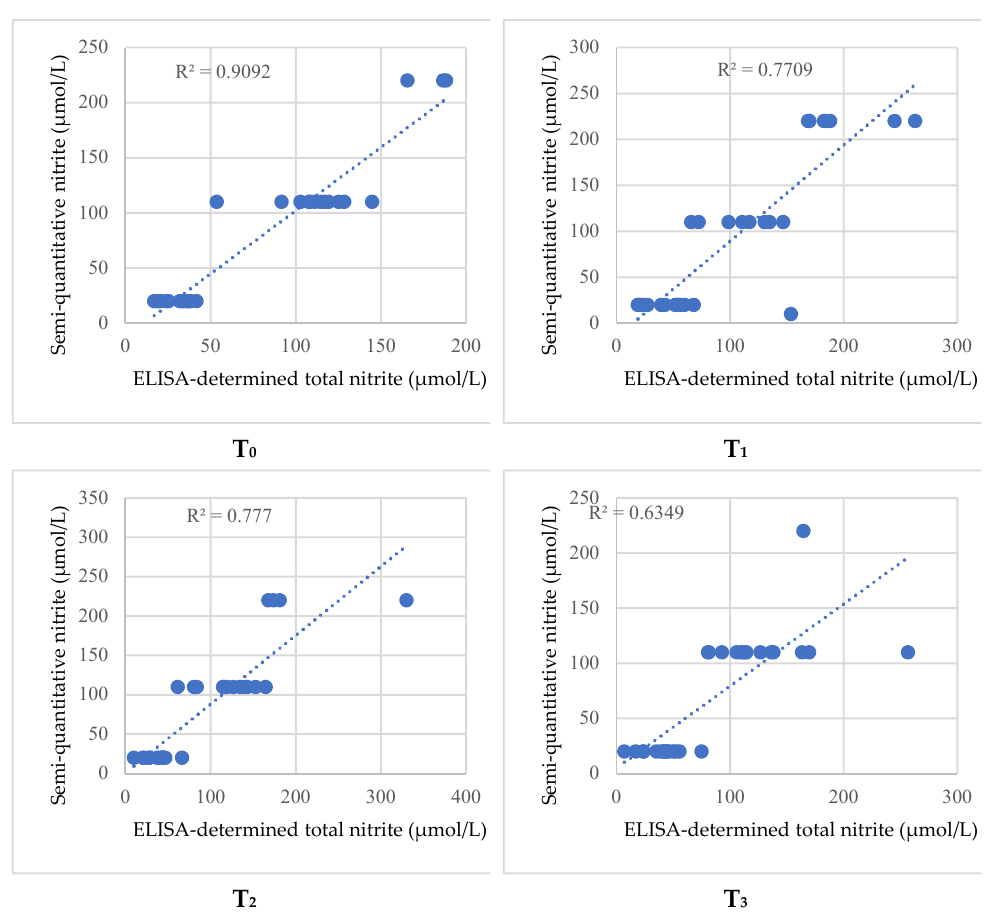
Figure 1. Correlations between total nitrite determined by ELISA and by the semi-quantitative method at T 0 , T 1 , T 2 , T 3